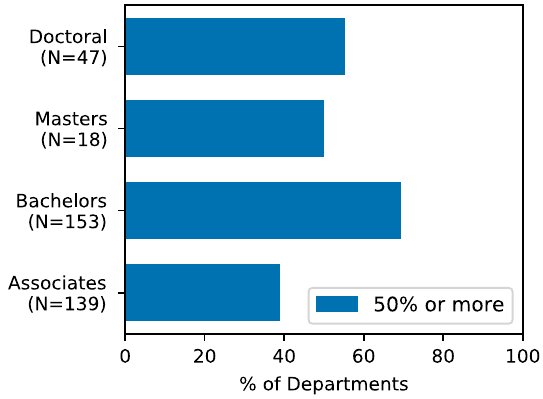
FIG. 6. The percentage of departments with a simple majority of surveyed faculty at an institution reporting that they have experience teaching computation varies by the highest degree that students can earn in